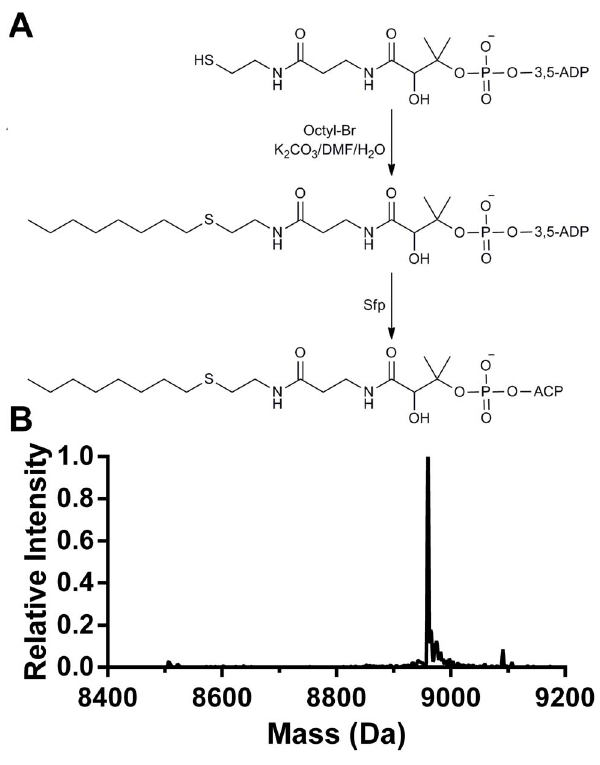
Figure 5. Chemoenzymatic synthesis of octyl-ACP sulfide. A) Synthesis of octyl ACP. In this two-step reaction, octyl-CoA sulfide was first synthesized by coupling octyl bromide with Coenzyme A, followed by enzymatic transfer of the alkyl-PPant to apo-ACP using Bacillus subtilis Sfp PPant transferase (see materials and methods). B) Mass spectrum of purified octyl-ACP. The intensity is relative to the largest peak of 8960 Da. The expected mass is 8957 Da.